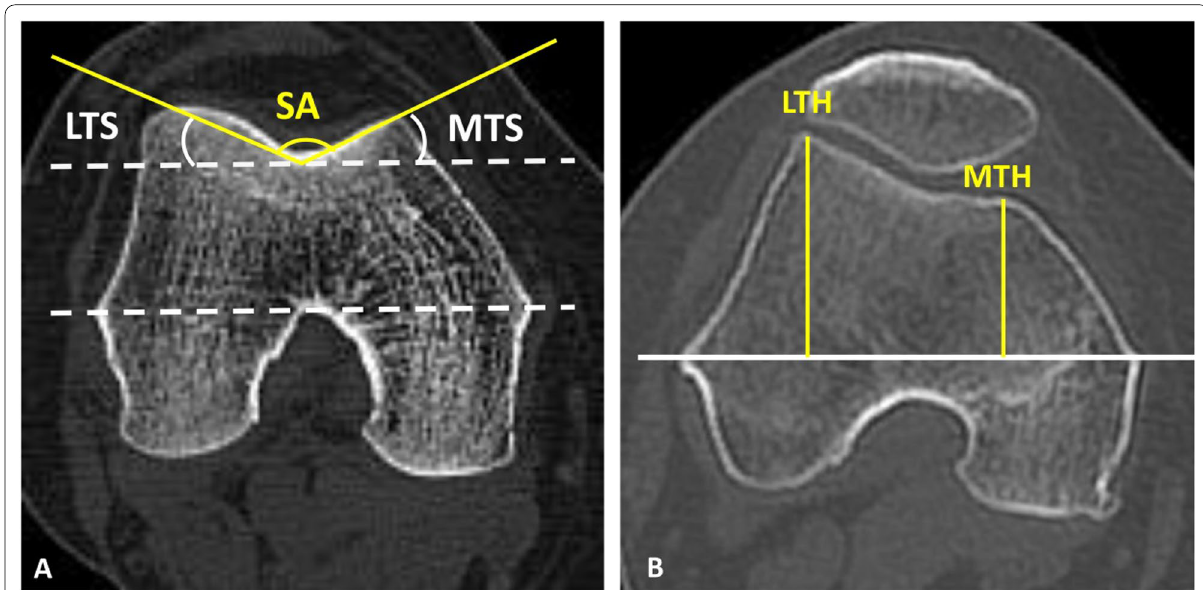
Fig. 3 Measurements of the morphology of the femoral trochlea. A SA: angle formed by the deepest point of the trochlear groove and the top points of the lateral and medial anterior condyles. LTS and MTS: angle formed between the TEA and the line connecting the deepest point of the trochlear groove and the top point of the lateral or medial anterior condyle, respectively. B LTH and MTH: length of the perpendicular line connecting the TEA and the top point of lateral or medial anterior condyle,